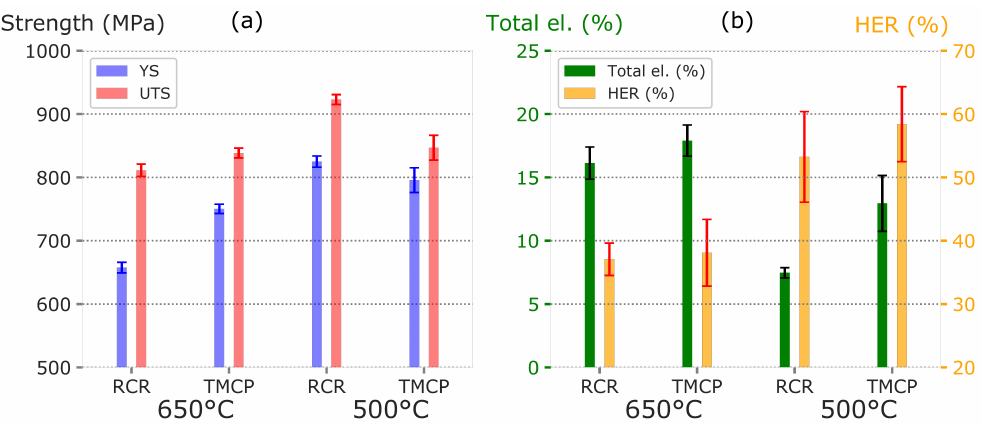
Figure 8. Mechanical properties of pilot plant hot-rolled plates, measured along the rolling direction. ( a ) Yield and ultimate tensile strengths. ( b ) Ductility properties : Total and uniform